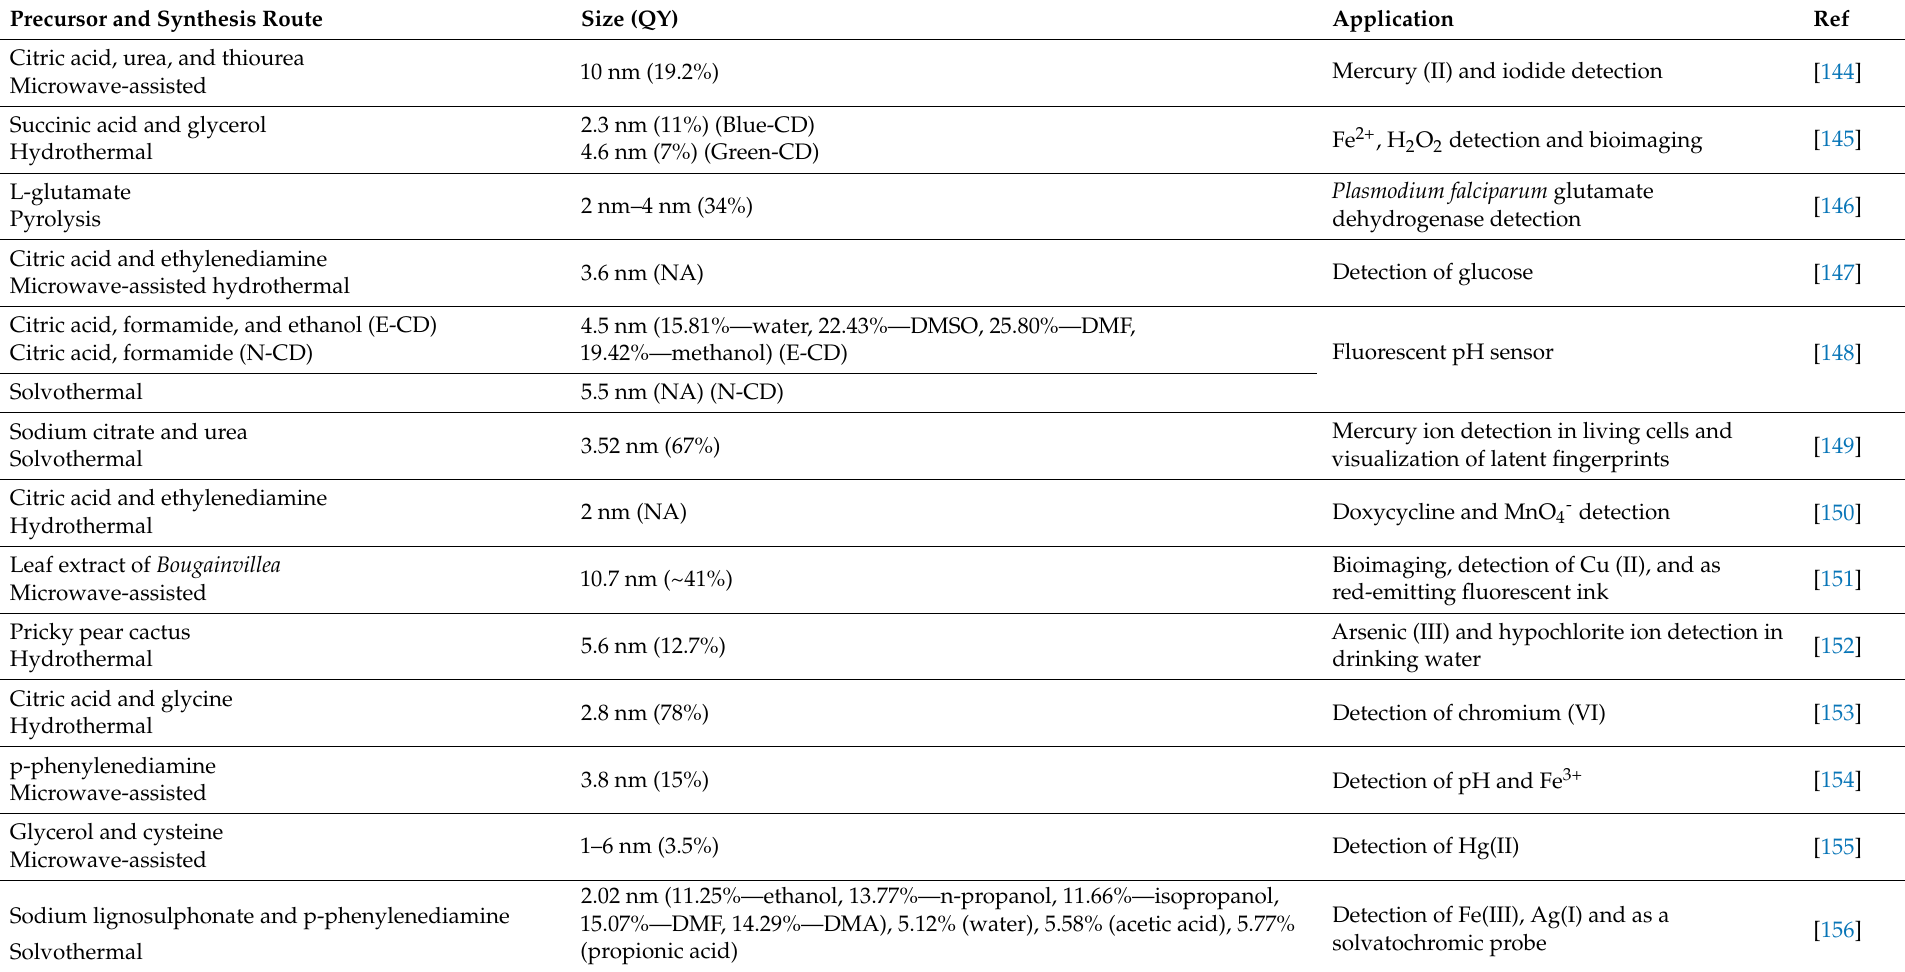
Table 3. Carbon dot-based photoluminescence